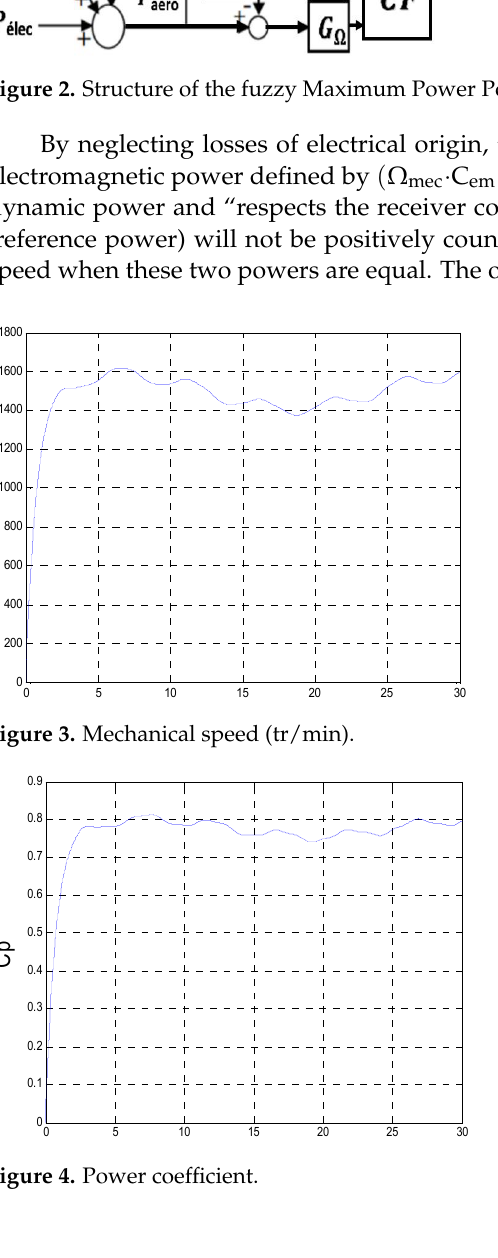
Figure 5. Torque produced. Figure 6. Electric power (N.m). We see that the Cp reached an average value of 0.78; it aims to be maintained as much as possible in order to optimize output, and it varies somewhat depending on changes in wind speed. 6. Current Rotor Prediction Prediction It is important to utilize both the direct and quadrature components of the rotor current in the following function [25]: